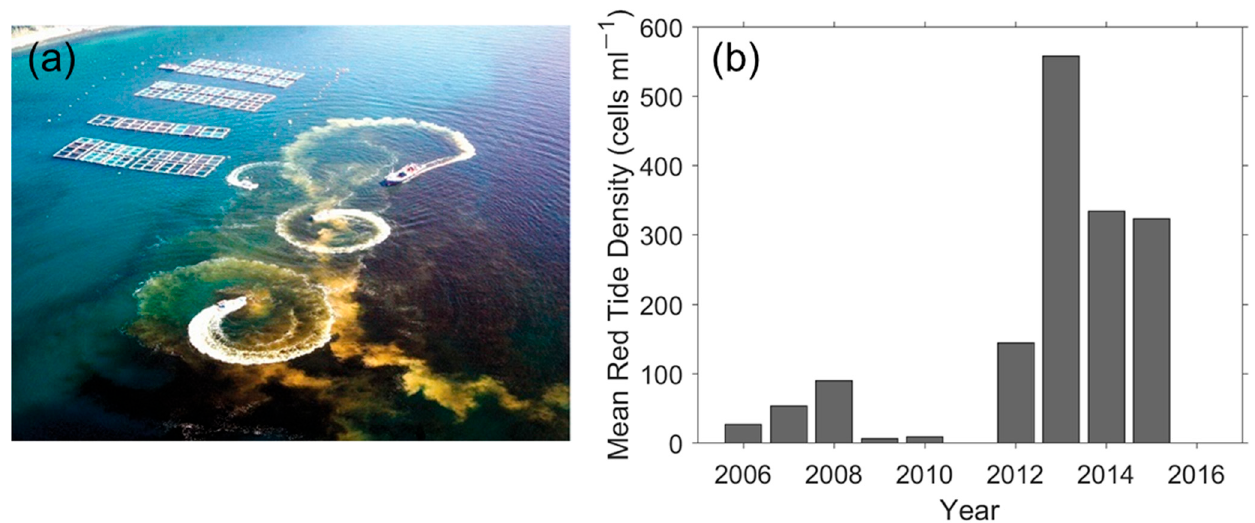
Figure 2. ( a ) Red tide prevention work creating turbulence and spreading yellow soil on red tide on the southern coast of Korea (National Institute of Fisheries Science, NIFS); ( b ) annual mean red tide density from 2006 to 2016 (source: NIFS red tide report).